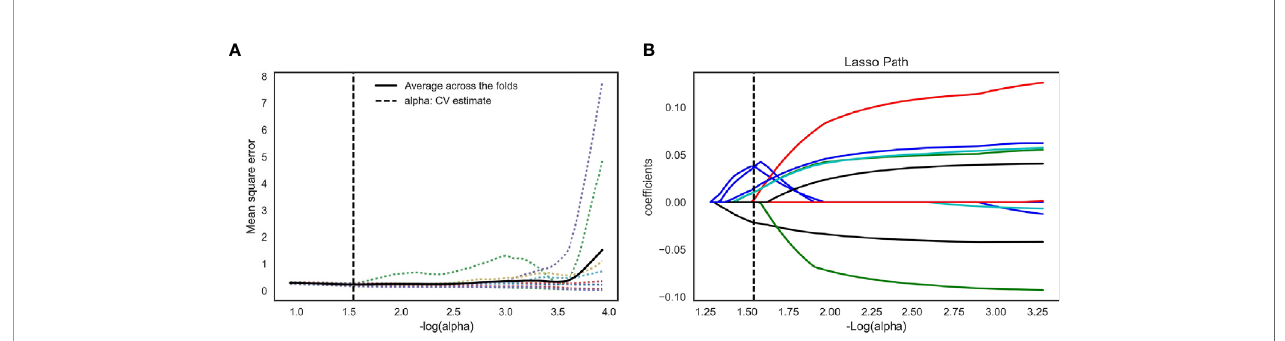
FIGURE 3 | Feature selection for the LASSO logistic regression and the predictive accuracy of the radiomics signature. (A) Tuning parameter ( l ) selection by 10-fold cross-validation with minimum criteria. Mean square error (y-axis) was plotted as a function of log( l ) (x-axis). The dotted vertical lines were drawn at the optimal value of l , where the model provided its best fi t of the data. The optimal value -log(alpha) = 1.50 (B) LASSO coef fi cient pro fi les for the whole features. The dotted vertical line was plotted at the value selected with 10-fold cross-validation, where eleven optimal features with nonzero coef fi cients are indicated in the plot.